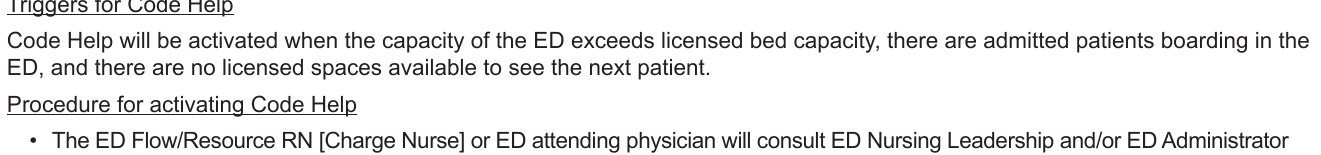
Table 1. Text of the Code Help